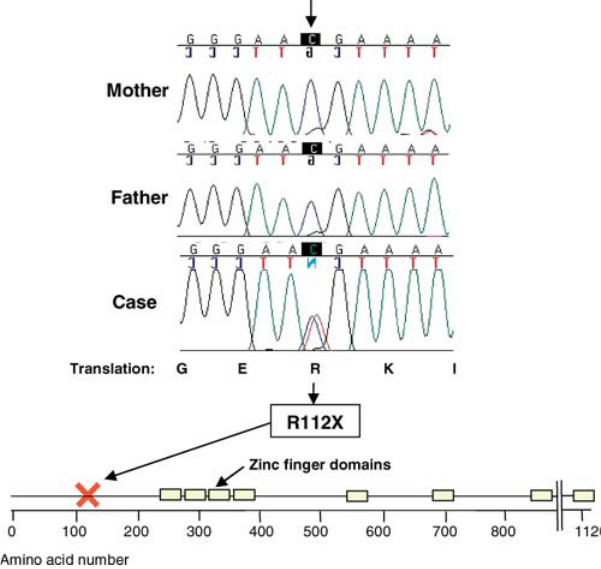
Figure 7. FOG2 Mutation in a Patient with Diaphragm and Lung Abnormalities Sequencing revealed a de novo heterozygote nonsense mutation in a patient who died at birth with severe pulmonary hypoplasia and a posterior deep diaphragmatic eventration. She was clinically diagnosed with CDH. This nonsense mutation occurs prior to the functional zinc finger domains. DOI: 10.1371/journal.pgen.0010010.g007 PLoS Genetics |